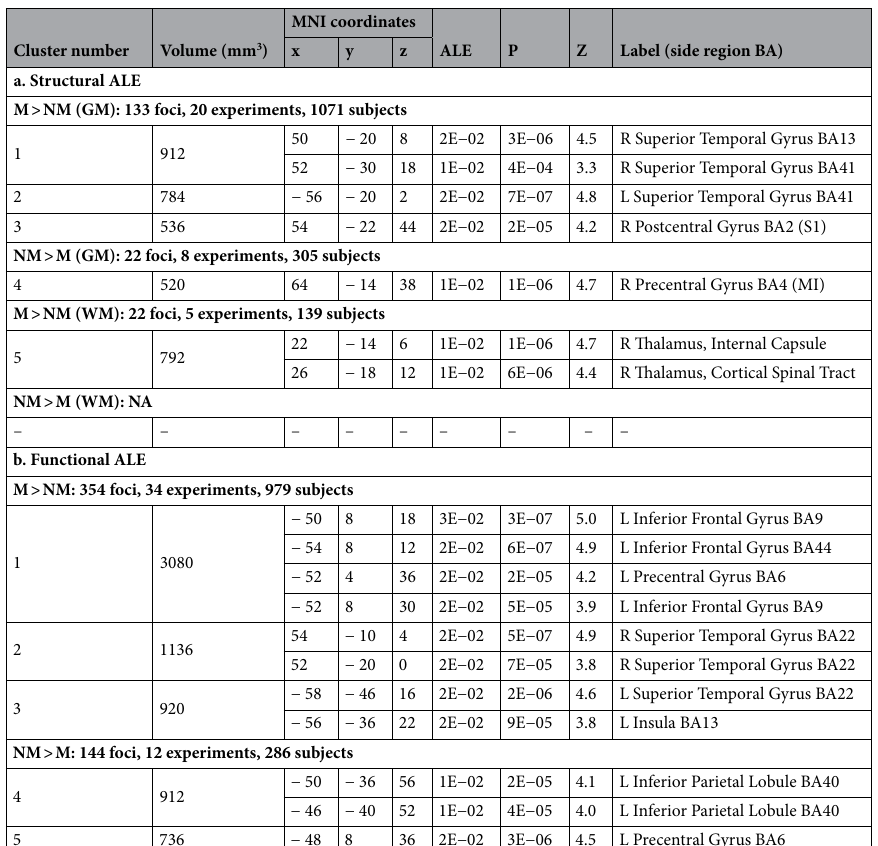
Table 2. ALE meta-analytic results for structural and functional studies comparing M vs NM at cluster level inference p < 0.05 (FWE). ALE anatomic likelihood estimation, M musicians, NM non-musicians, GM grey matter, WM white matter, BA Brodmann area, P p-value, Z peak z-value, R right, L left, NA not enough available observations.